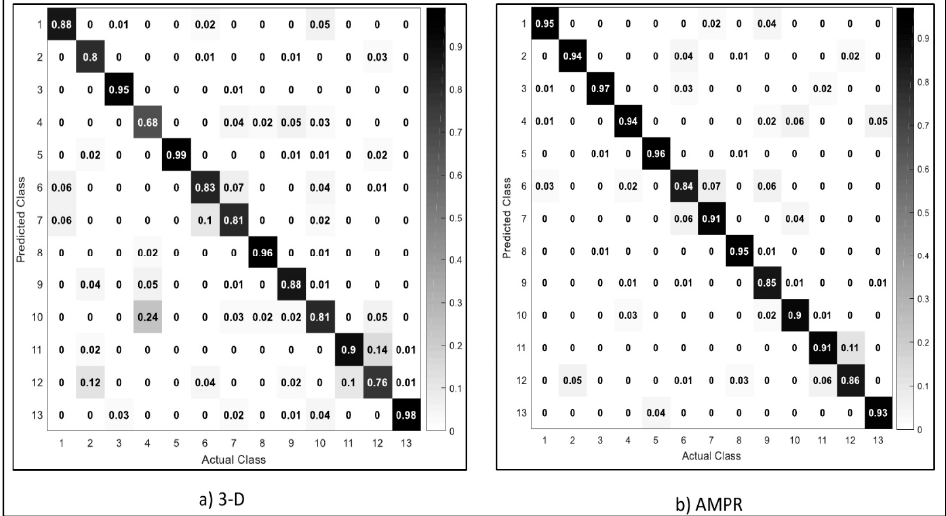
Figure 10. Confusion matrix for deep belief networks. Note: 3-D (3-D acceleration), AMPR (fusion of